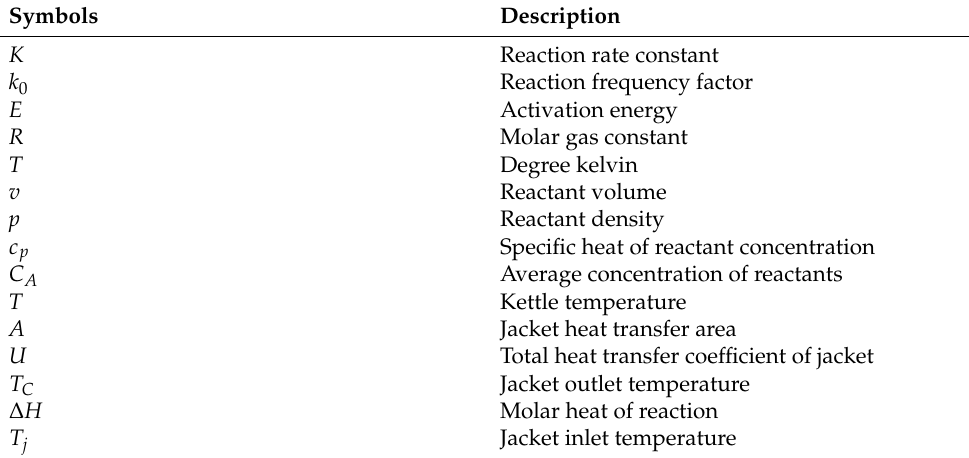
Table 1. Operating parameters of the reactor tank description.